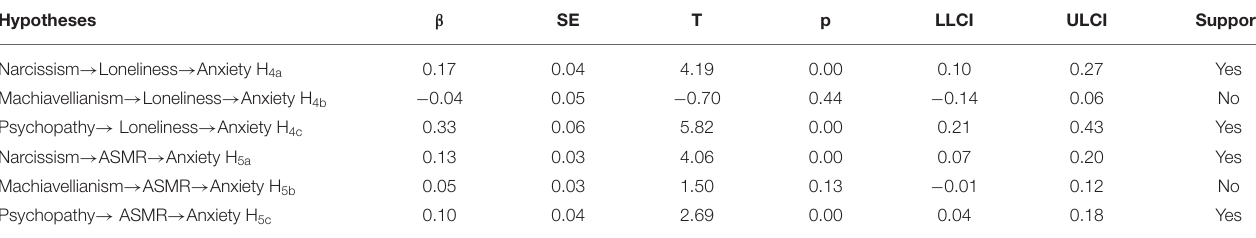
TABLE 5 | Indirect effects (mediation